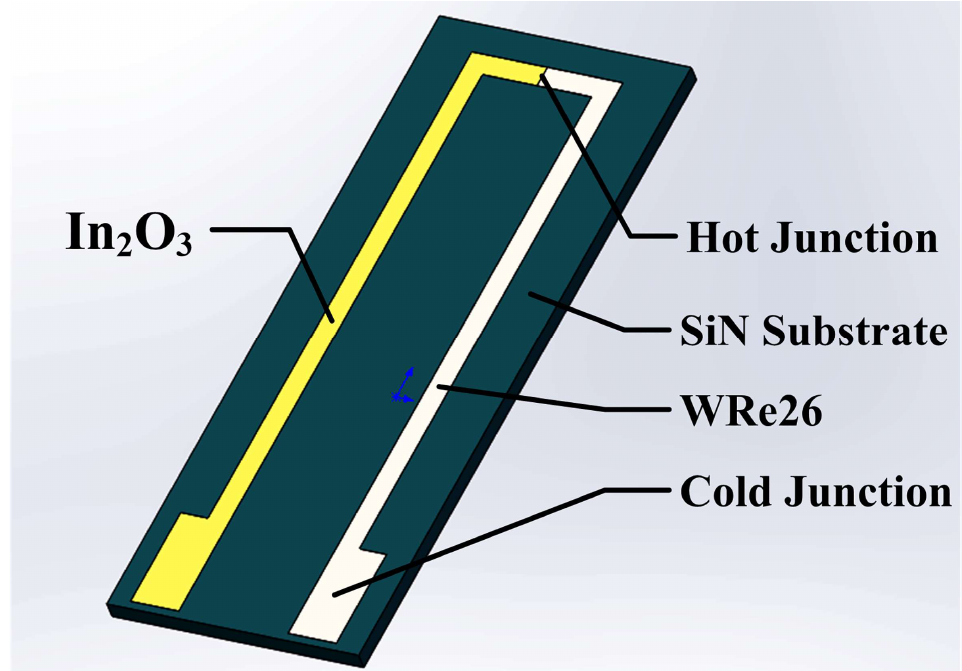
Figure 4. Structure of WRe26-In 2 O 3 TFTCs.